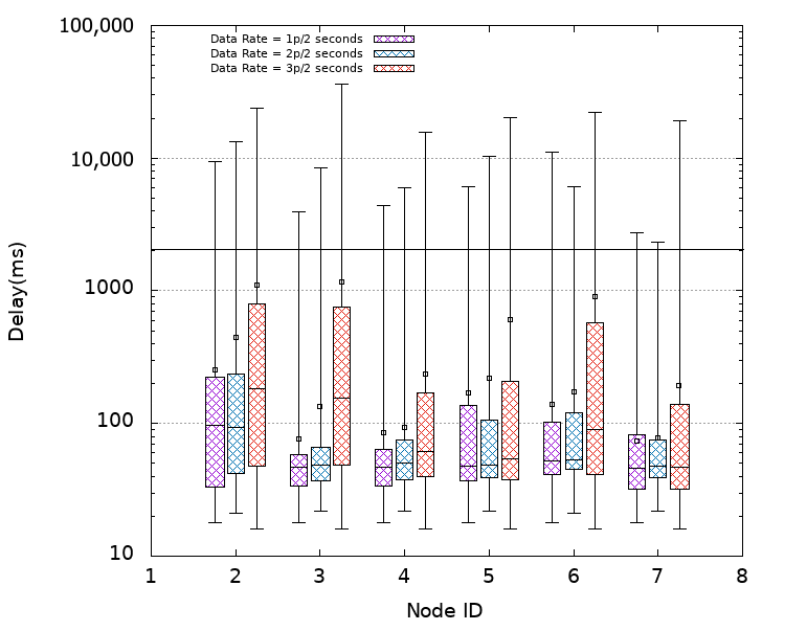
Figure 8. Packet Delay—Minimal